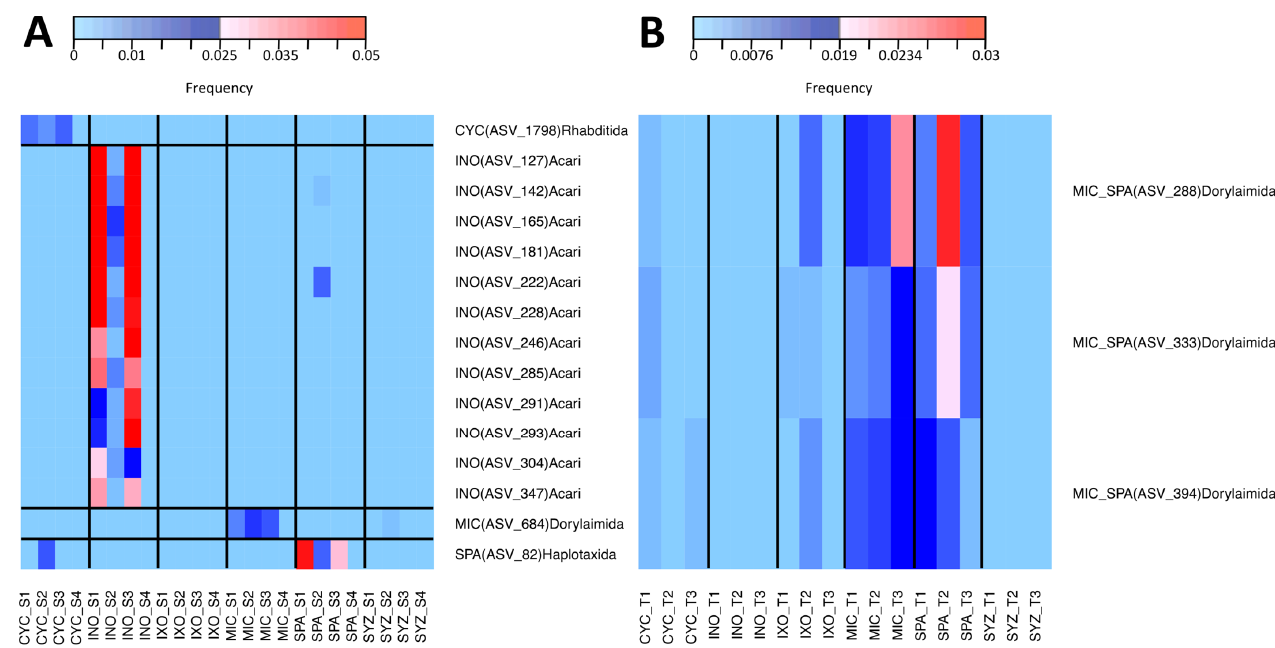
Figure 5. Heatmap of specific metazoan ASVs. Only ASVs specific to a single plant species or to both MIC and SPA are shown for the seedling and tree stages, respectively. For each ASV, the name of the associated plant species is indicated as well as its taxonomic annotation. CYC: Cyclophyllum barbatum , INO: Inocarpus fagifer , IXO: Ixora mooreensis , MIC: Miconia calvescens , SPA: Spathodea campanulata , SYZ: Syzygium malaccense . ASV: amplicon sequence variant. ( A ) Seedling stage. S: seedling. ( B ) Tree stage. T: tree. Table 1. Developmental effects on soil diversity. p values are indicated based on a PERMANOVA. Significant p values are in